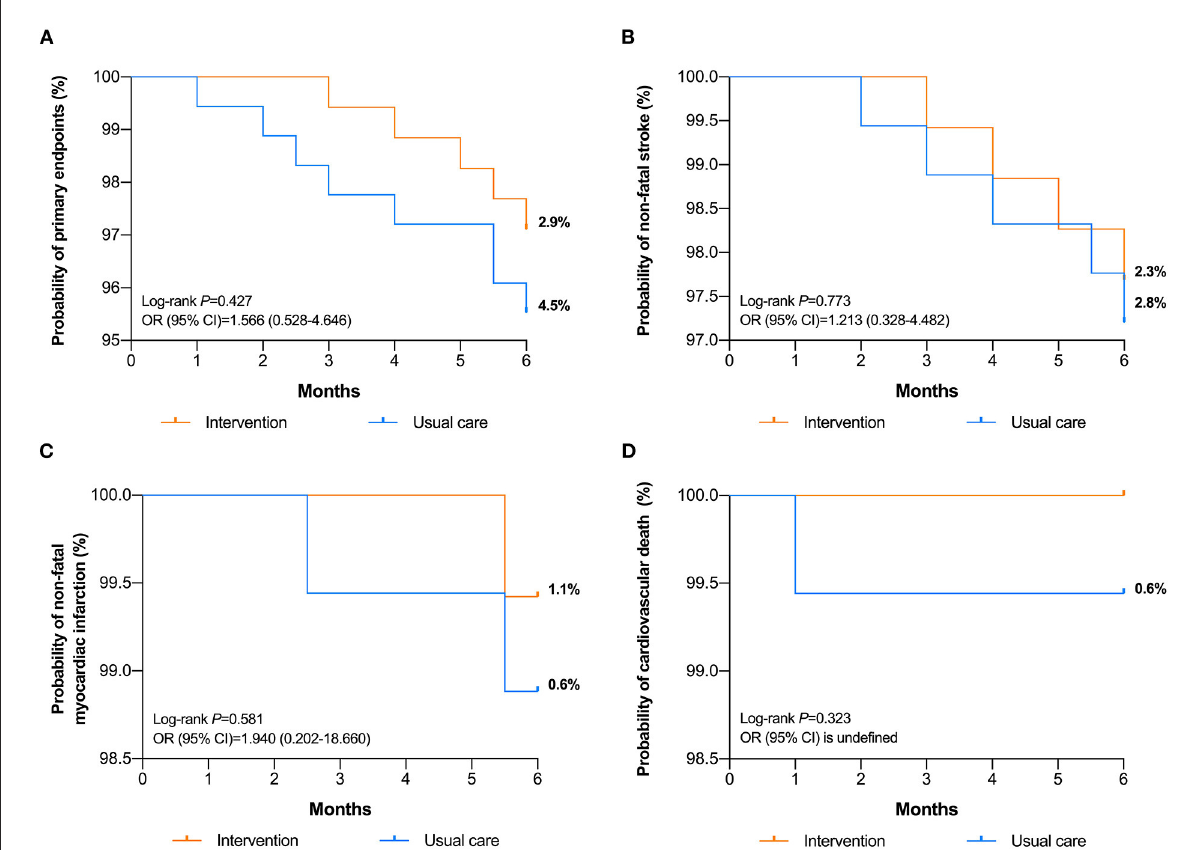
FIGURE4 Kaplan-Meier cumulative curves for (A) composite of events, (B) non-fatal stroke, (C) non-fatal myocadiac infarction, and (D) cardiovascular death between intervention and UC